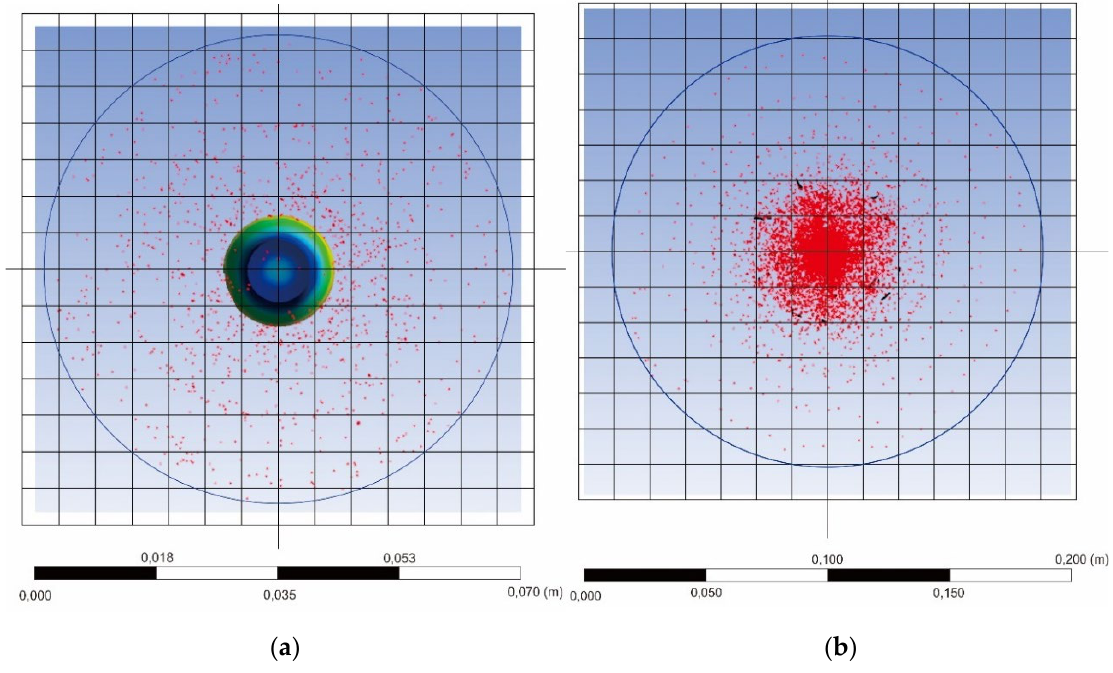
Figure 10. Fragmentation pattern of the projectile ( a ) AMMO 1; ( b ) AMMO 2.